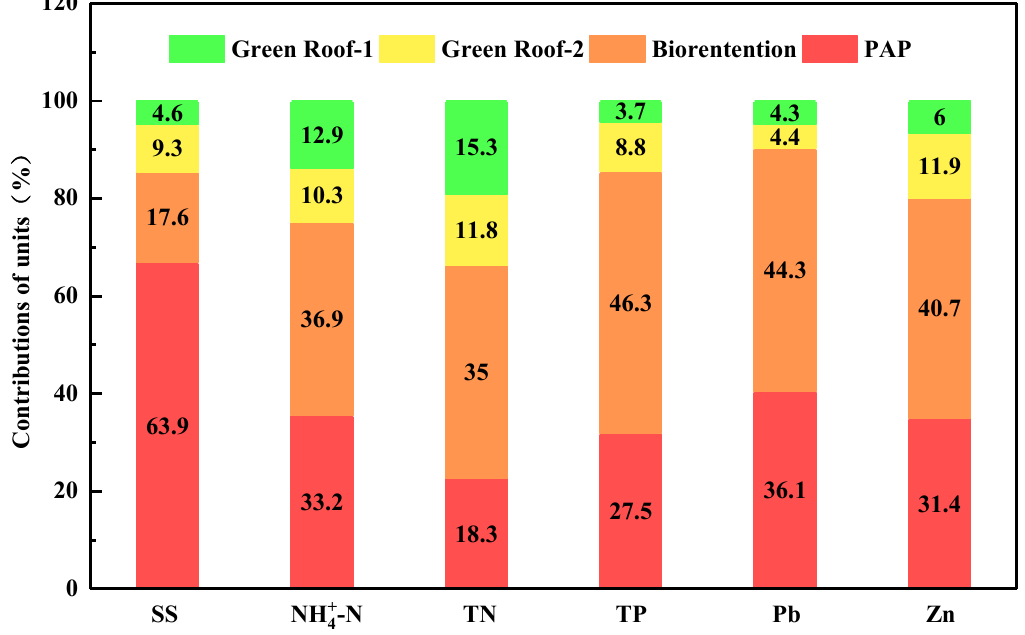
Figure 5. Contributions of each unit within the PBT-GR system to the removal of pollutants.